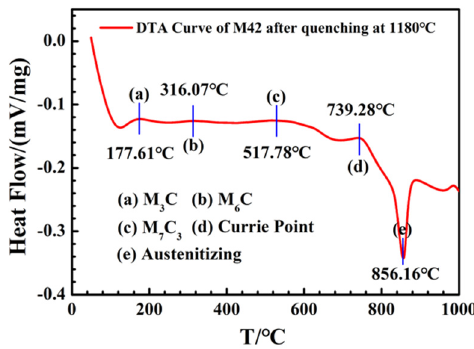
Figure 6. Differential Scanning Calorimetry (DSC) curve of M42 HSS after Quenching at 1180 °C.